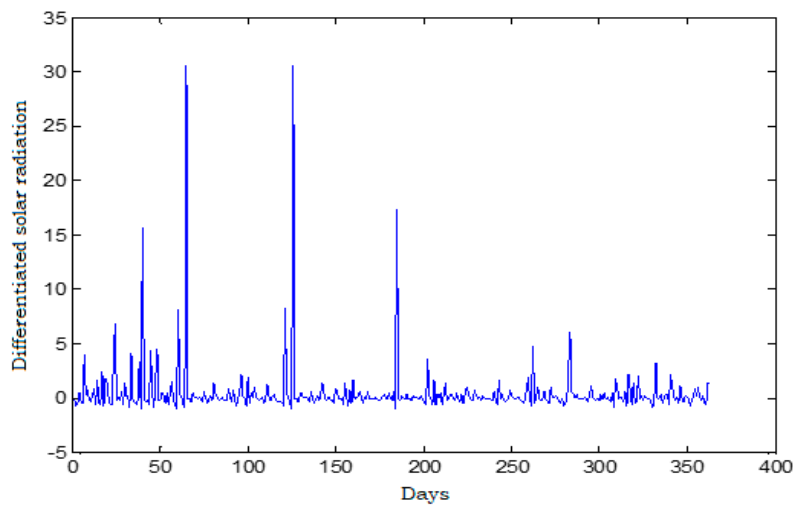
Figure 14. Solar radiation evolution along a year (daily radiation averages).